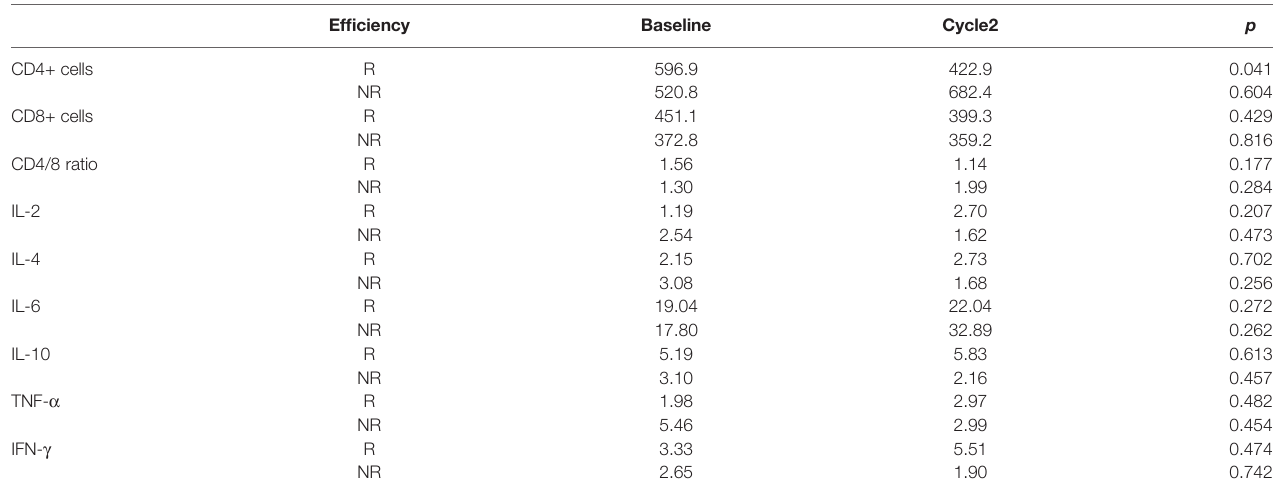
TABLE 5 | Summary of phenotypic and cytokines analyses of patients.